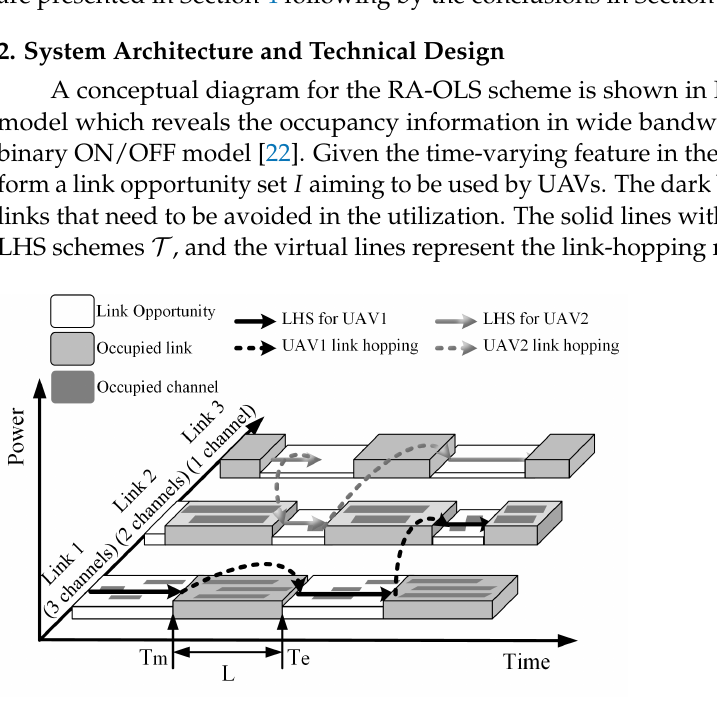
Figure 1. Demonstration of a spectrum occupation diagram enabled by the RA-OLS scheme.